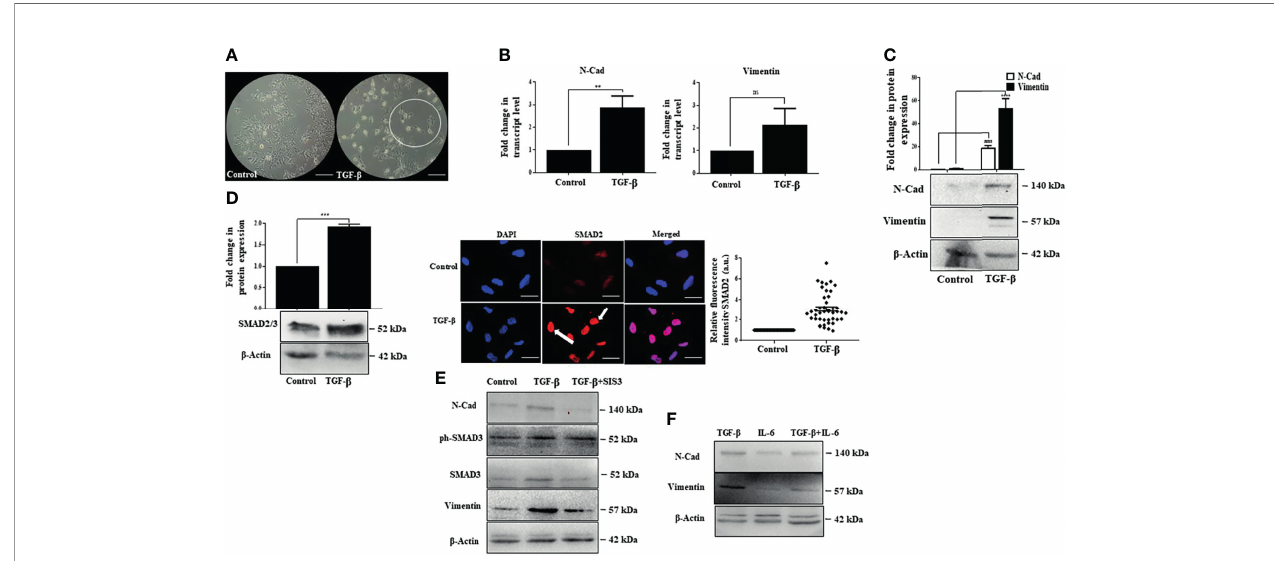
FIGURE 5 | IL-6 fails to enhance TGF- b -induced SMAD-dependent EMT. (A) Phase-contrast images of TGF- b treated cells after 72 h of exposure compared to those of untreated control (scale bar: 100 m m). The encircled area represents morphologically distinct cells. (B) Transcript levels of N-Cad and vimentin after TGF- b treatment compared to those of untreated control. (C) Immunoblot showing expression of N-Cad and vimentin after TGF- b exposure for 72 h. (D) Immunoblot showing expression of SMAD2/3 after TGF- b treatment for 72 h; immuno fl uorescence image and relative fl uorescence intensity of SMAD2 after TGF- b treatment (scale bar: 10 m m). The white arrow denotes SMAD2 protein. (E) Immunoblot showing SMAD3, N-Cad, and vimentin expression in cells treated with TGF- b or TGF- b plus SIS3 for 72 h (F) Immunoblot showing expression of N-Cad and vimentin after exposure to TGF- b or IL-6 or in combination for 72 h. **, *** and ns refers to p